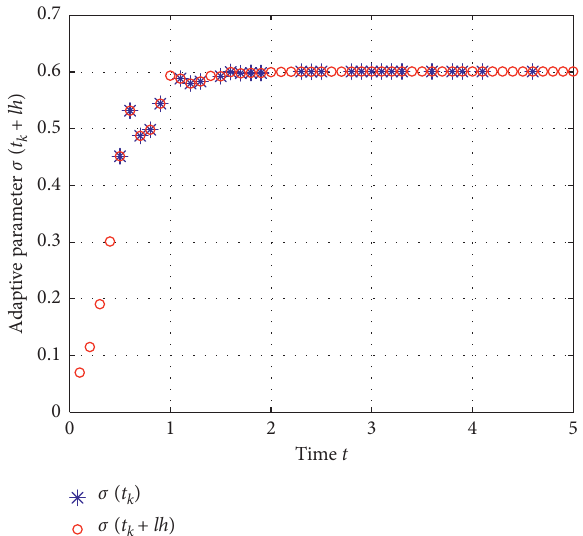
Figure 4: Adaptive parameters of AEIC scheme for Example 1.